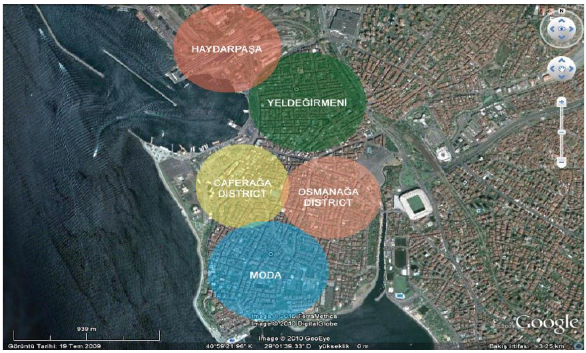
Figure 2. Settlement of Central Kadıköy (Developed by